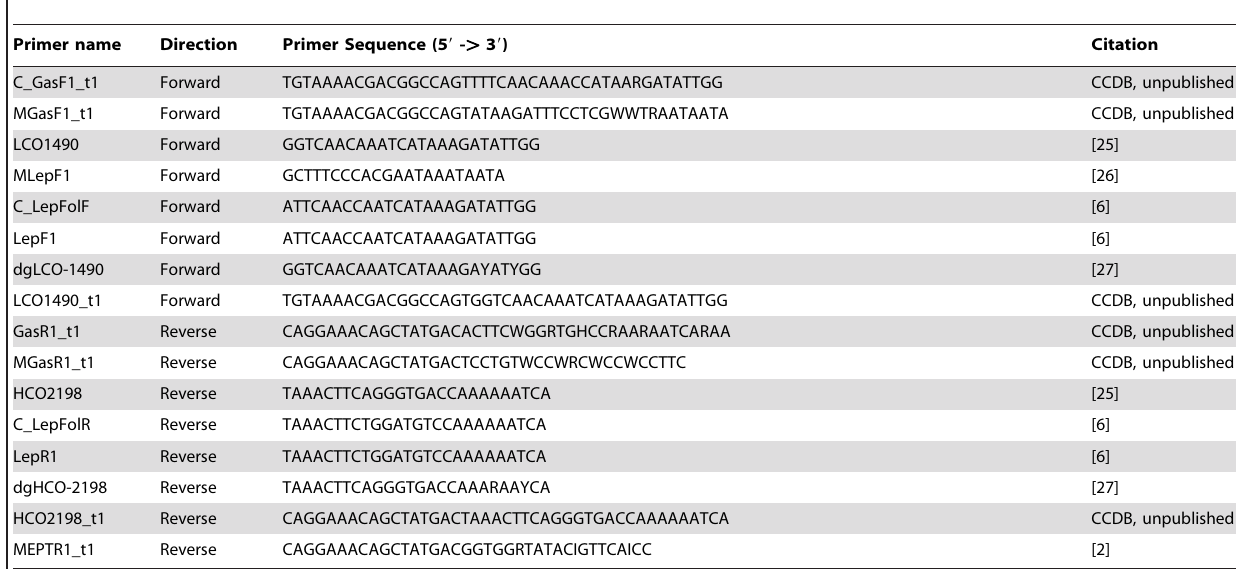
Table 3. Primers, direction, primer sequence and citation (if available) for all sequences from this study.